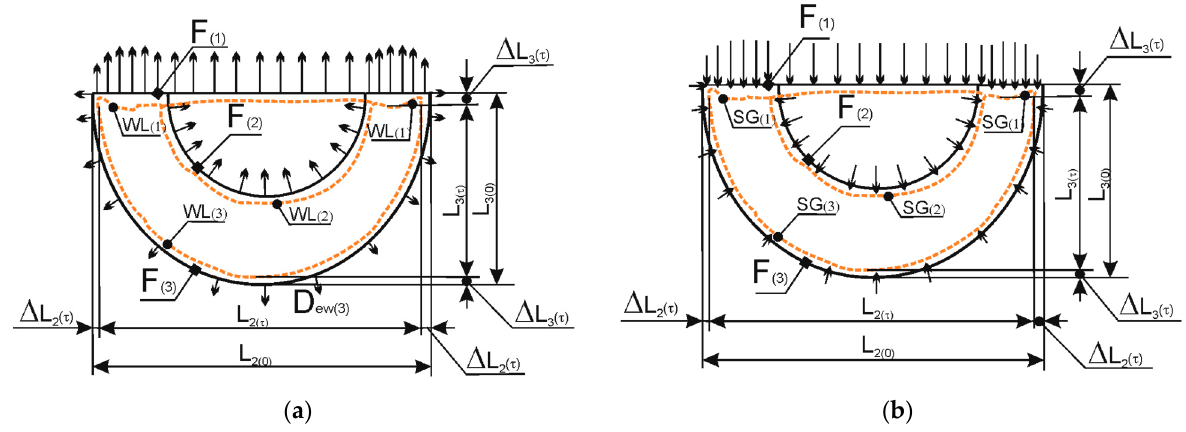
Figure 8. Cross-section of the apricot halves with shrinkage and mass transfer during osmotic dehydration: ( a ) Water loss (WL); ( b ) Solid gain (SG). F (1) —Surface after cutting; F (2) —Surface after the stone was removed; F (3) —Surface; L 2(0) , L 2( τ ) —Width of apricot half at the beginning of process and at time τ ; L 3(0) , L 3( τ ) —Thickness of apricot half at the beginning of process and at time τ ; WL (1) , WL (2) , WL (3) —Water loss through surfaces F( 1 ), F( 2 ), F( 3 ); SG (1) , SG (2) , SG (3) —solid gain through surfaces F( 1 ), F( 2 ), F( 3 ); Δ —difference; → direction of water and solute diffusion, ▪▪▪▪ —dash line dimensions after OD.